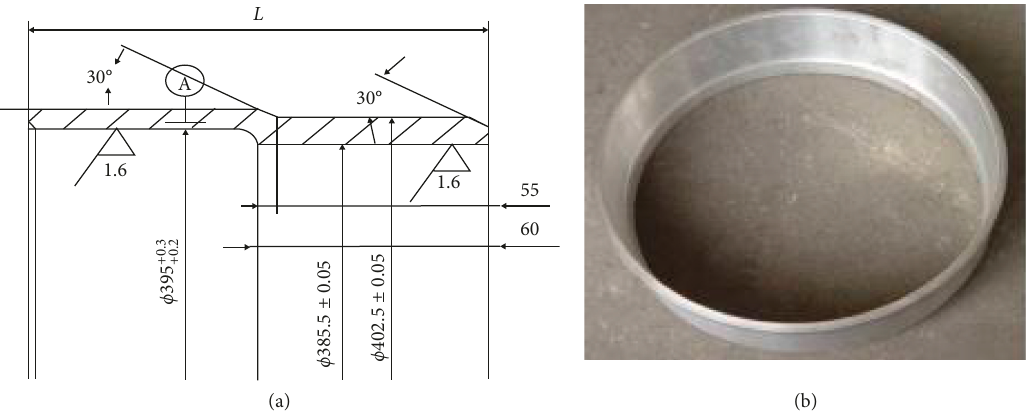
Figure 16: (a) Workblank drawings and (b) the workblank.